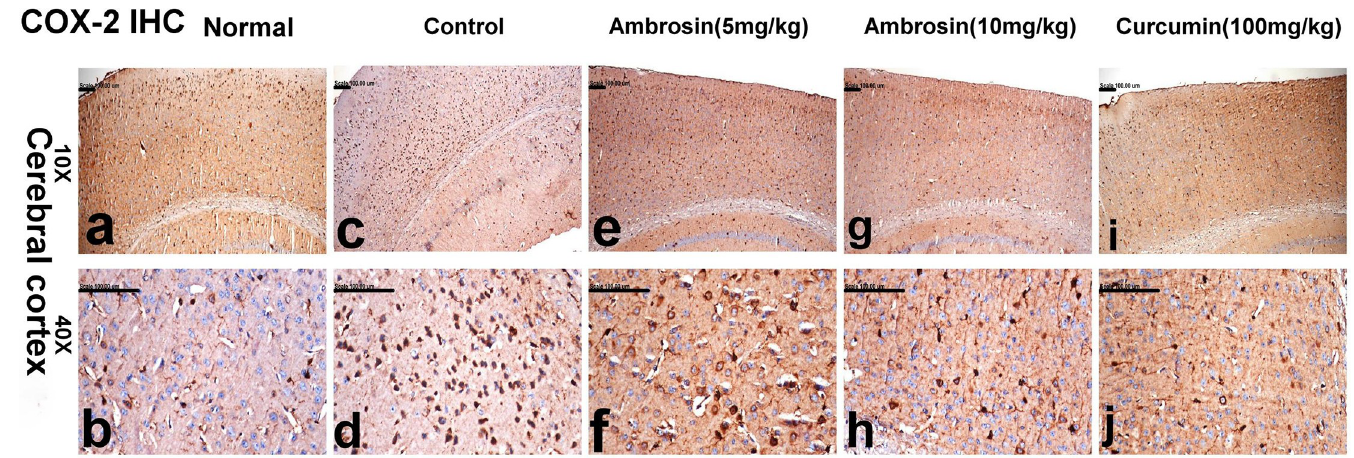
Fig 11. COX-2 immune-stained neurons in the brain sections of mice (magnifications: 10X, 40X). The photomicrograph illustrates the following groups: (a, b) normal mice showing insignificant COX-2-immune positive cells, (c, d) control mice showing significant increase of COX-2 expression in the cerebral cortical neurons, (e, f) Ambrosin (5 mg/kg/day) treated mice showing reduction of COX-2 expression, (g, h) Ambrosin (10 mg/kg/day) treated mice showing COX-2 expression in fewer numbers of neurons, and (i, j) Curcumin treated mice showing individual COX-2 immune-stained cells. (COX-2 immunohistochemical stain). https://doi.org/10.1371/journal.pone.0219378.g011 ( Table 4). The cells appeared hypertrophied with enlarged cell bodies surrounding amyloid plaques ( Fig 12C and 12D). Reduced CD68 immune reactivity was recorded in ambrosin (5 mg/kg) (0.20 ± 0.01) ( Fig 12E and 12F) being significantly different from the control group. 12G and 12H) and curcumin groups (0.15 ± 0.01 and 0.13 ± 0.01, respectively) in which small